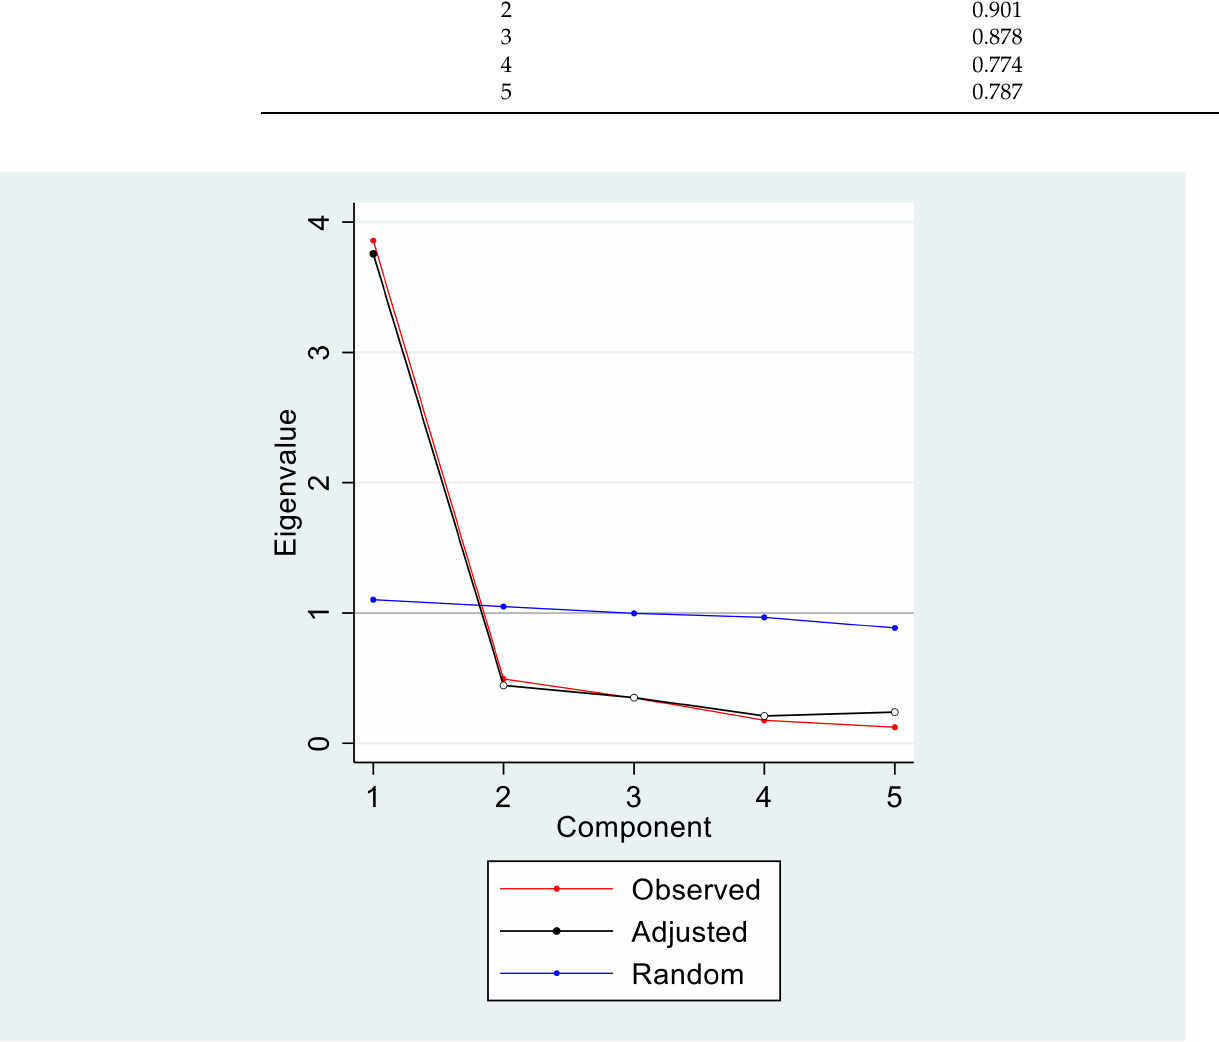
Figure 1. Scree plot (Study 1). As can be noted, one-component solution was found for the Hebrew version of the MDAS. The observed (red) and adjusted (black) both illustrate and support the one-component